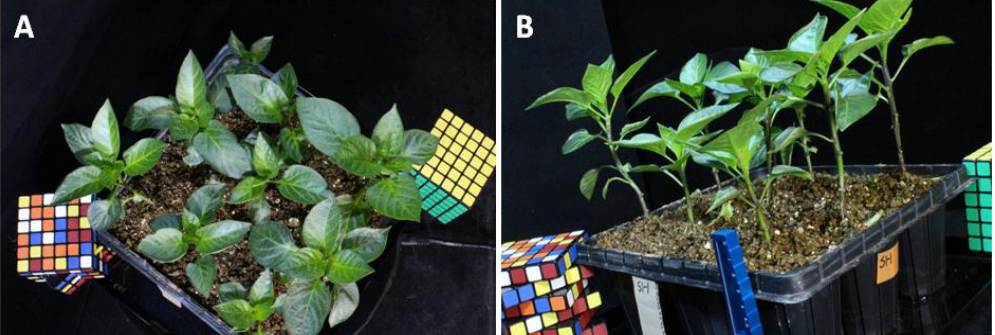
Figure 3. Original photos of paprika plants taken by the MCP-SfM system. ( A ) One of the original photos taken by a 28-mm lens at the 1st camera position; ( B ) One of the original photos taken by a 28-mm lens at the 3rd camera position.